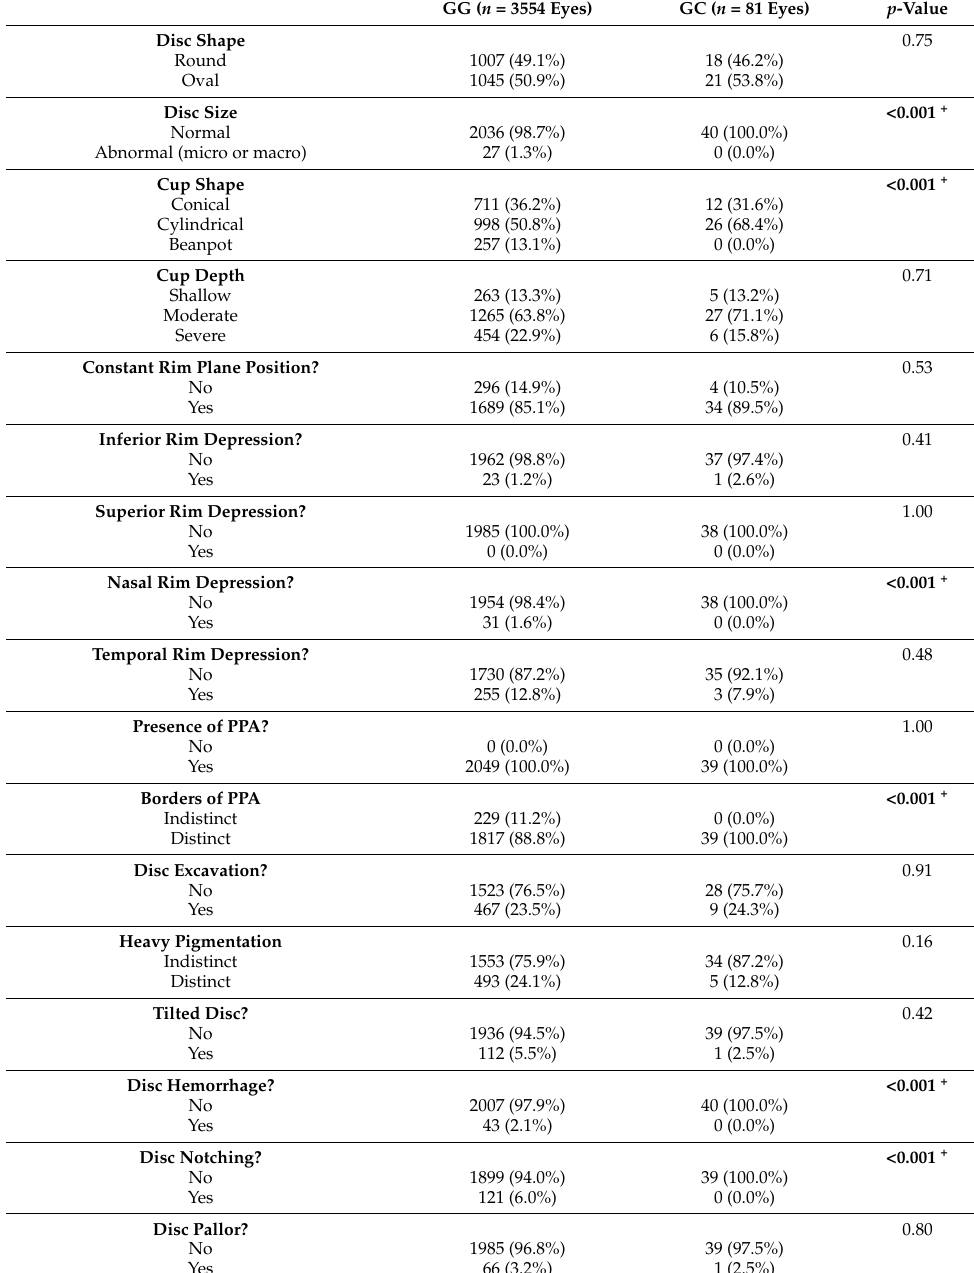
Table 4. Optic disc parameters by LMX1B genotype among